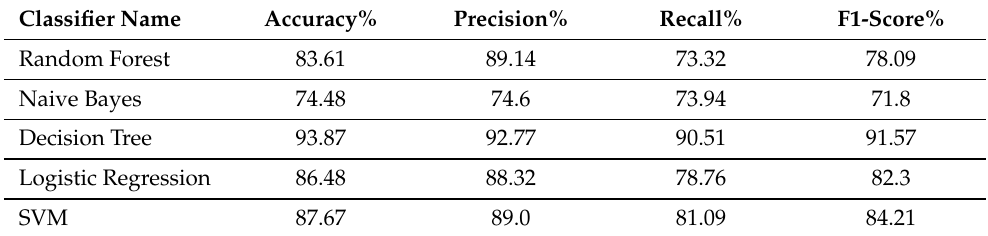
Table 8. Machine learning performance on Sinopharm vaccine dataset.